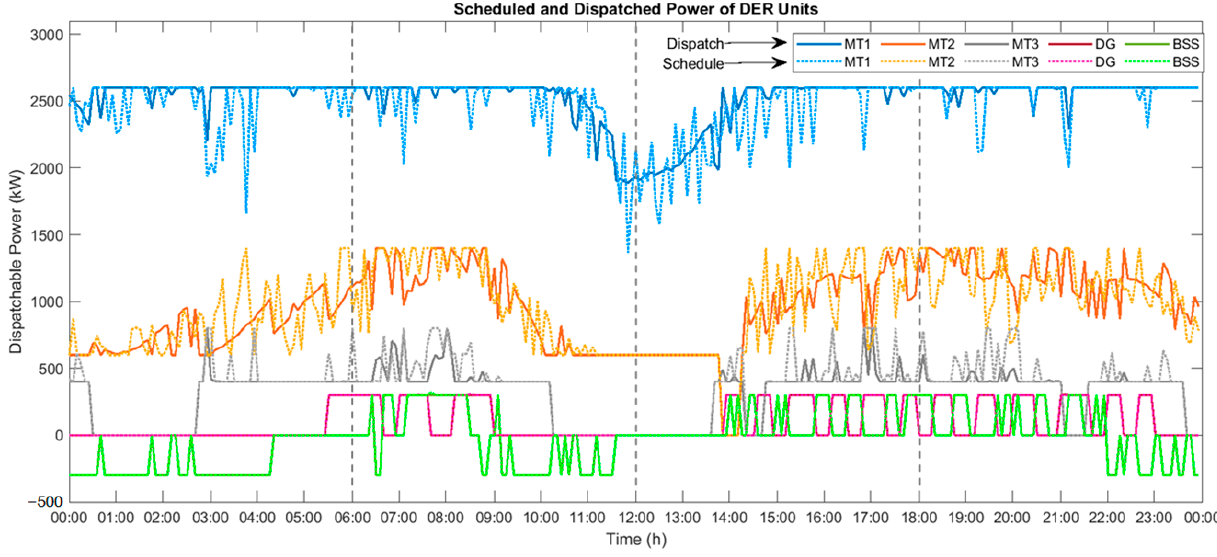
Figure 11. Simulation outcome for 69-bus system: scheduled and dispatched power of DER units. The key results from the simulations presented in this section are highlighted in Table 6. Table 6. Key observations from the presented simulations.